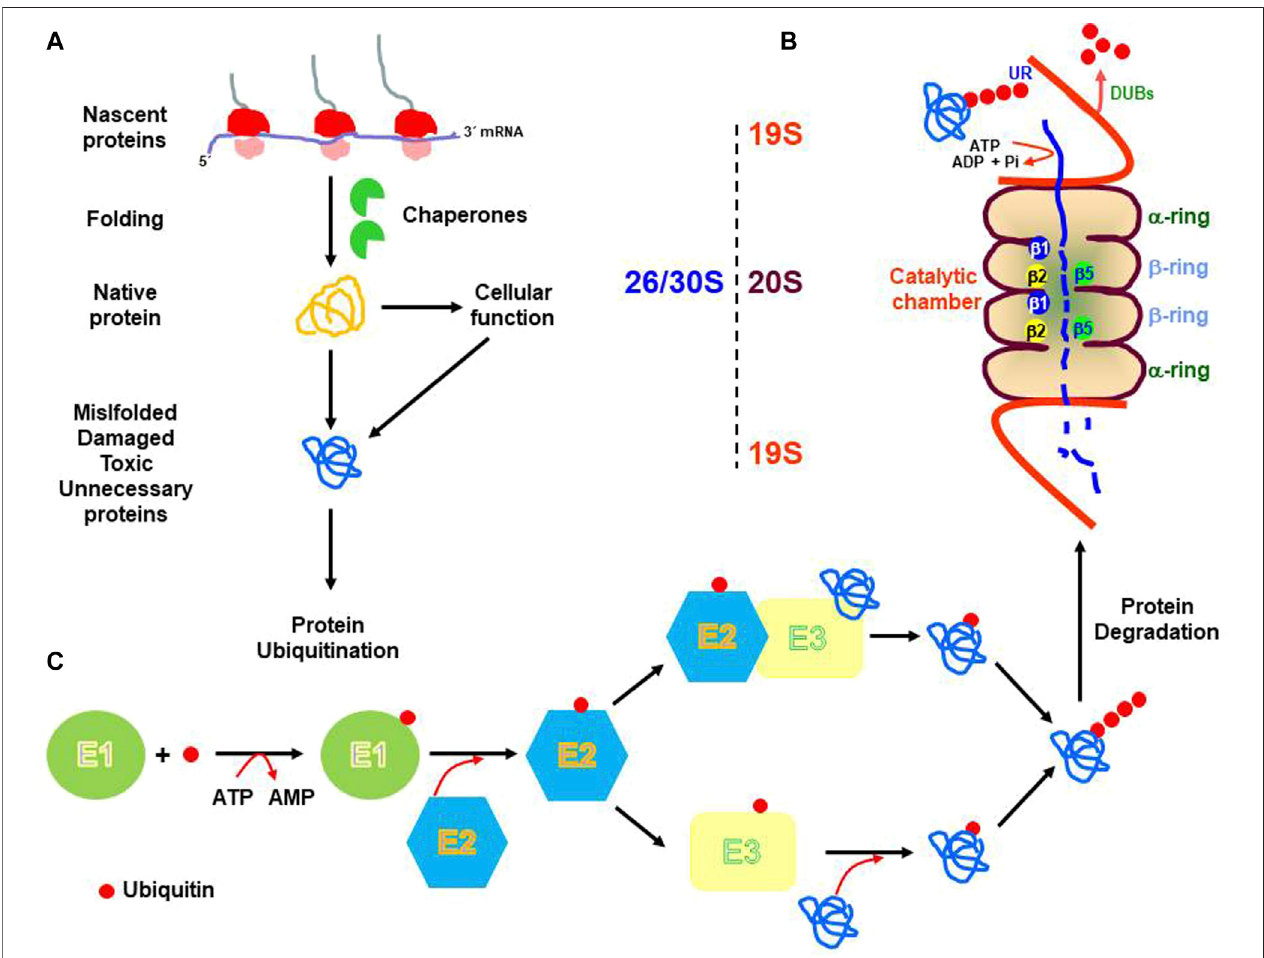
FIGURE 1 | Schematic representation of the cellular biology of proteins. mRNA translation produces nascent proteins that are assisted during folding by chaperones. Native proteins perform their cellular functions and are subject to cellular turnover (A) . Also, unfolded, misfolded, oxidative damage, modi fi ed, or unnecessary proteins are targeted for degradation by the 26S or 30S proteasome [19S-20S or 19S-20S-19S, respectively: (B) ]. Previous to proteasome degradation proteins need to be ubiquitinated by three enzymatic reactions catalyzed by the E1 (ubiquitin-activating), E2 ubiquitin-conjugating) and E3 (ubiquitin-ligase), respectively (C) . UR. Ubiquitin receptor; DUBs. Deubiquitinating enzymes. β 1, β 2, and β 5. Catalytic